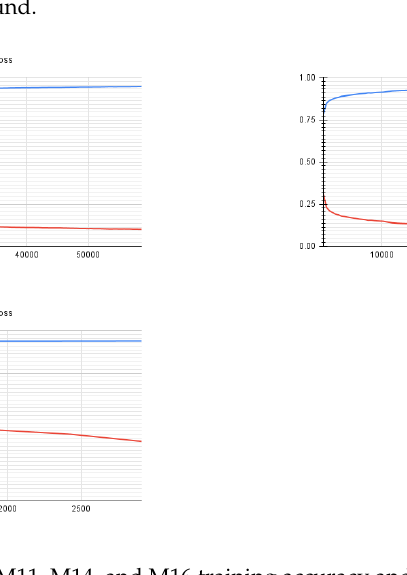
Figure 6. Potsdam models M11, M14, and M16 training accuracy and